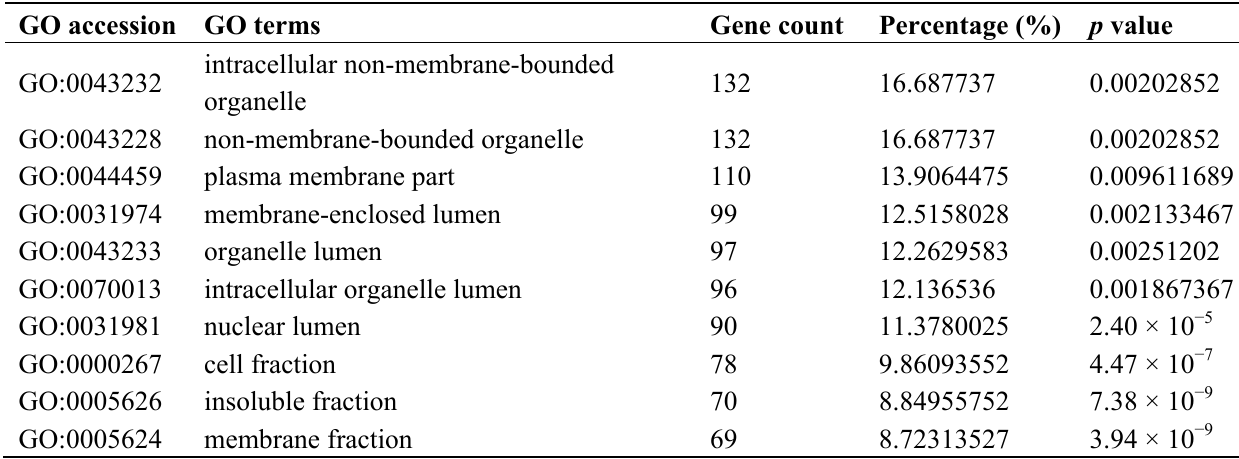
Table 7. The 10 most enriched GO categories in cellular component.